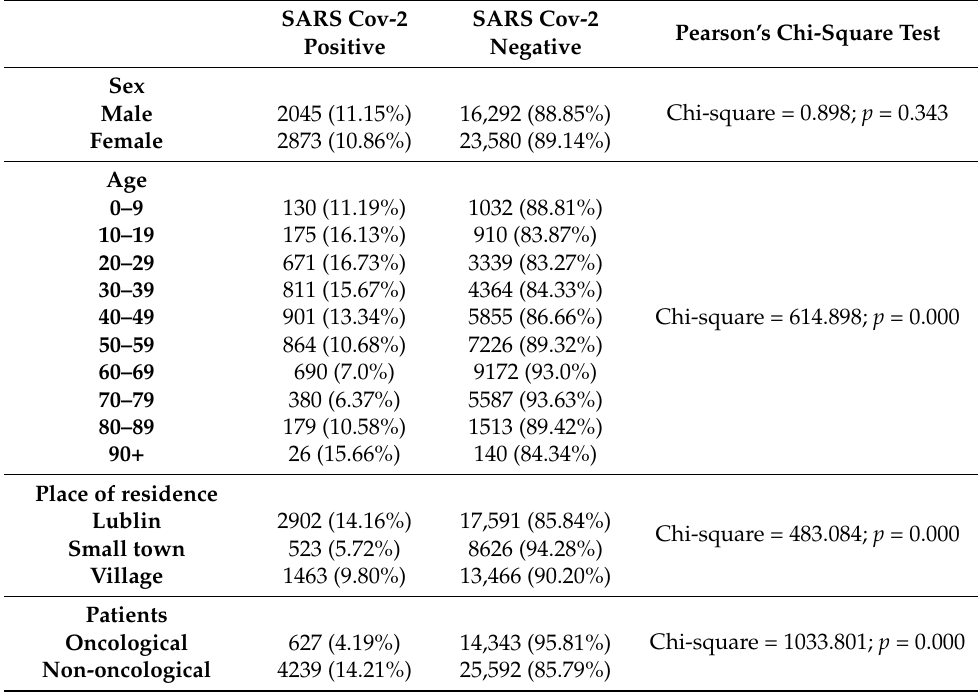
Table 2. Detection of SARS Cov-2 depending on socio-demographical